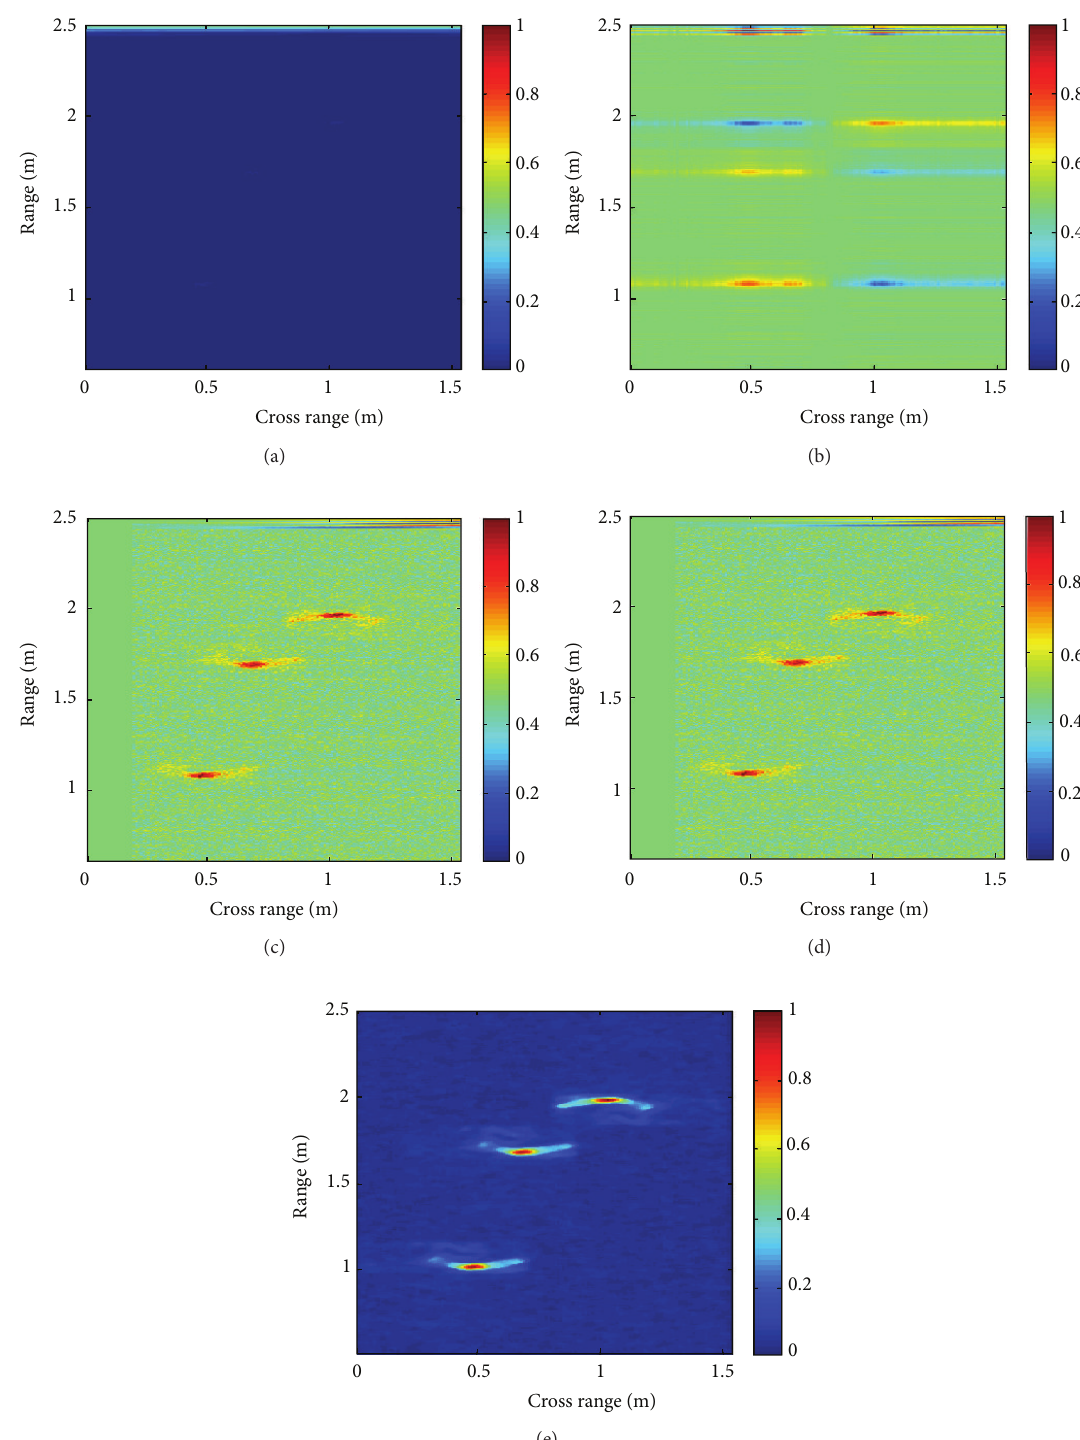
Figure 2: Image with three targets. (a) Original image. (b) SVD [11]. (c) Proposed fuzzy QRD (PIE). (d) Proposed fuzzy QRD (TS). (e) Background subtracted reference